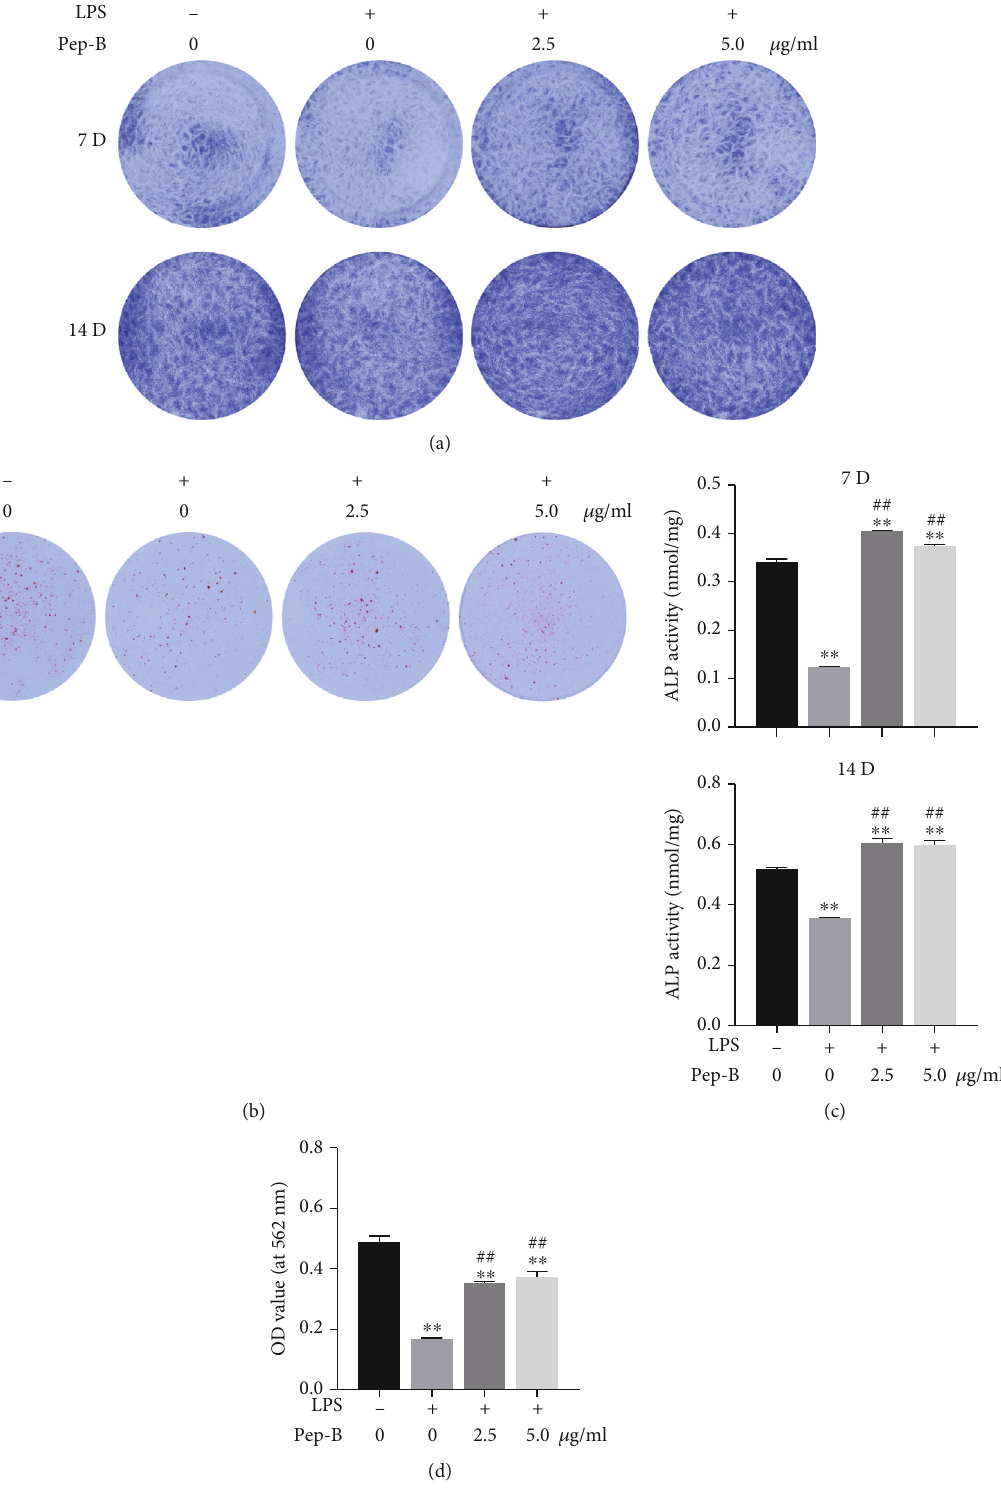
Figure 6: E ff ects of Pep-B on the osteoblast di ff erentiation in hDPSCs. Cells were treated with LPS (1 μ g/ml) in the presence or absence of Pep-B (2.5, 5 μ g/ml) in osteo-/odontoblast induced medium. (a) ALP staining and (c) ALP activity at 7 and 14 days. (b) ARS staining and (d) mineralization nodules quanti fi cation at 14 days. ∗∗ , ## P < 0 : 01 , ∗ represents comparison with the control group, # represents comparison with the LPS